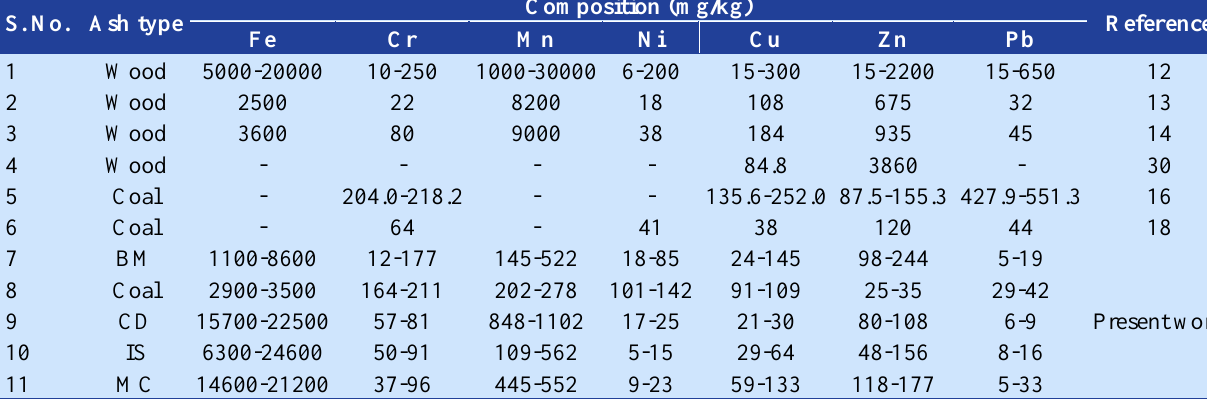
Table 6. Comparison of metals in ash residues in various studies S. No. Ash